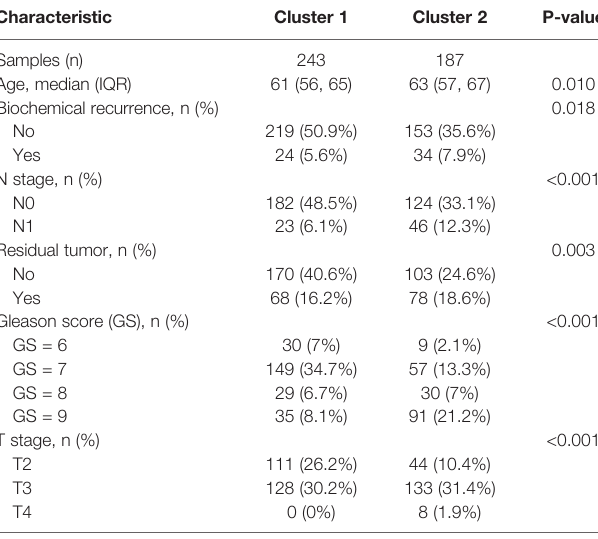
IQR, interquartile range; GS, Gleason score.